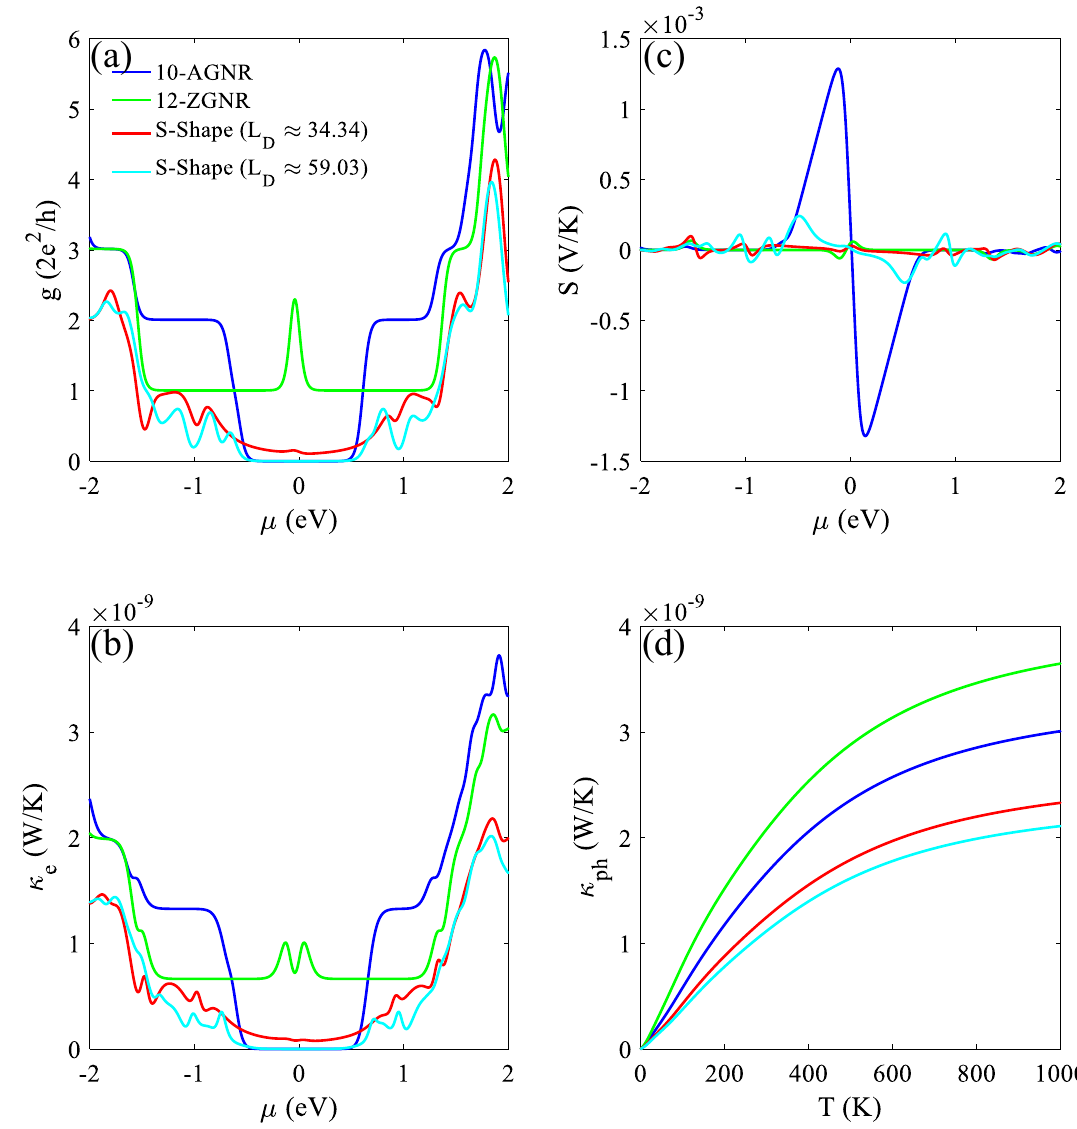
Figure 6. ( a ) Electronic conductance, ( b ) electronic thermal conductance, and ( c ) Seebeck coefficient versus the chemical potential for 10-AGNR (blue line), 12-ZGNR (green line), and two different lengths of the S-shape graphene structure (short S-shape graphene nanoribbon with the red line. The cyan line is for the longer length). ( d ) Phononic thermal conductance as a function of